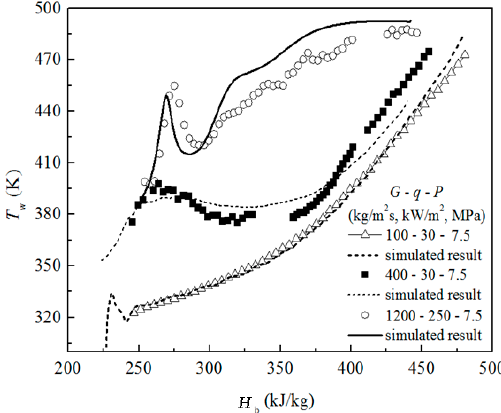
Figure 15. Comparison of the simulated and experimental results.